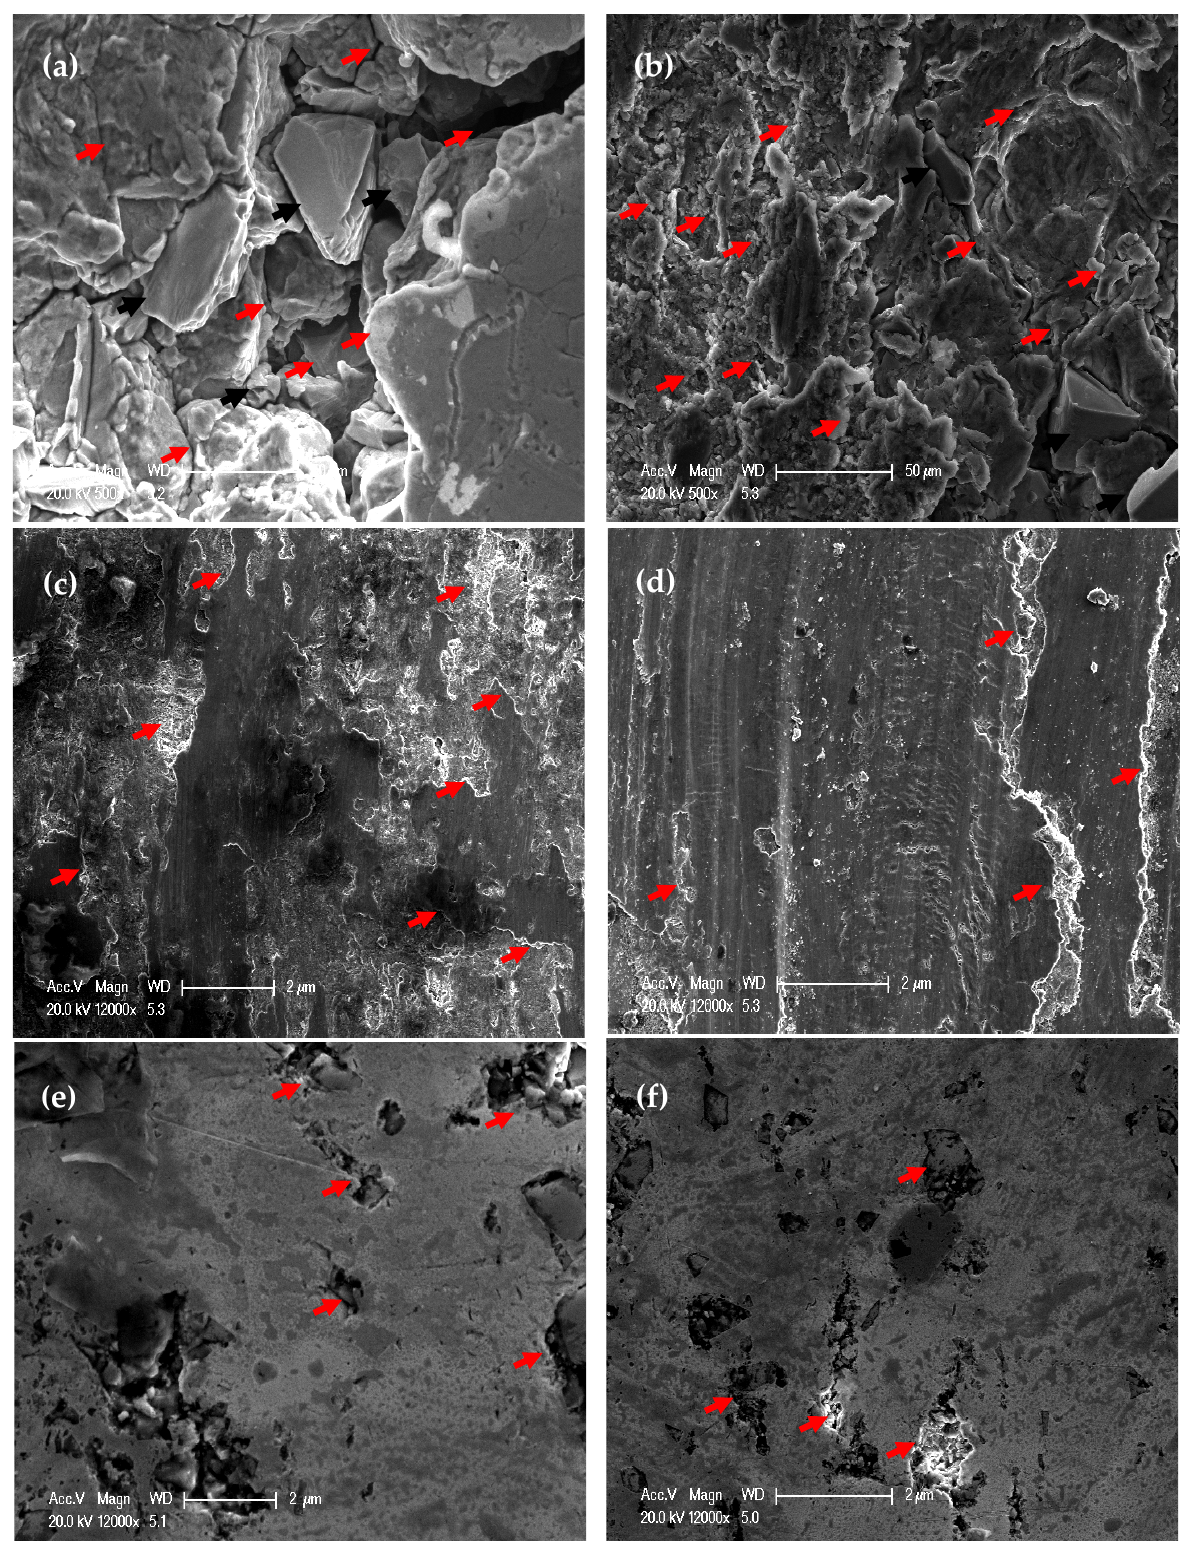
Figure 14. Worn surface morphology of ( a ) PM Al-20% Al 2 O 3 , ( b ) PM Al-20% SiC, ( c ) HPT-processed Al-10% Al 2 O 3 , ( d ) HPT-processed Al-10% SiC, ( e ) HPT-processed Al-20% Al 2 O 3 , and ( f ) HPT- processed Al-20% SiC samples obtained under an applied load of 20 N and a sliding distance of 1260